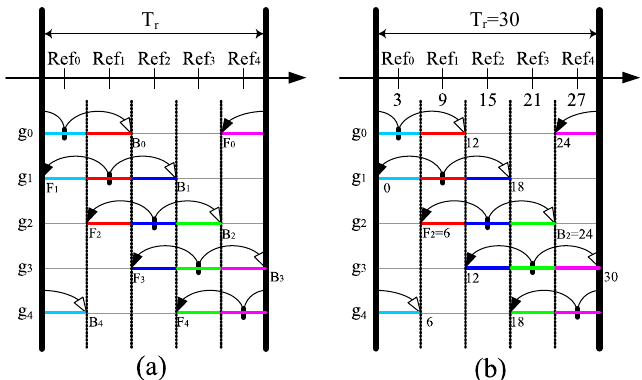
Figure 6. A sleep scheduling in Pre-Scheduling-based K -coverage Group Scheduling (PSKGS) for K = 3, ( a ) A theoretical representation; ( b ) an example